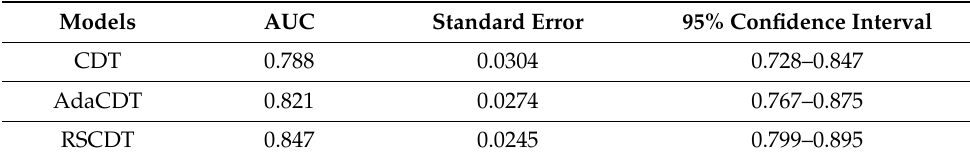
Table 5. ROC analysis of CDT, AdaCDT, and RSCDT models using training data.